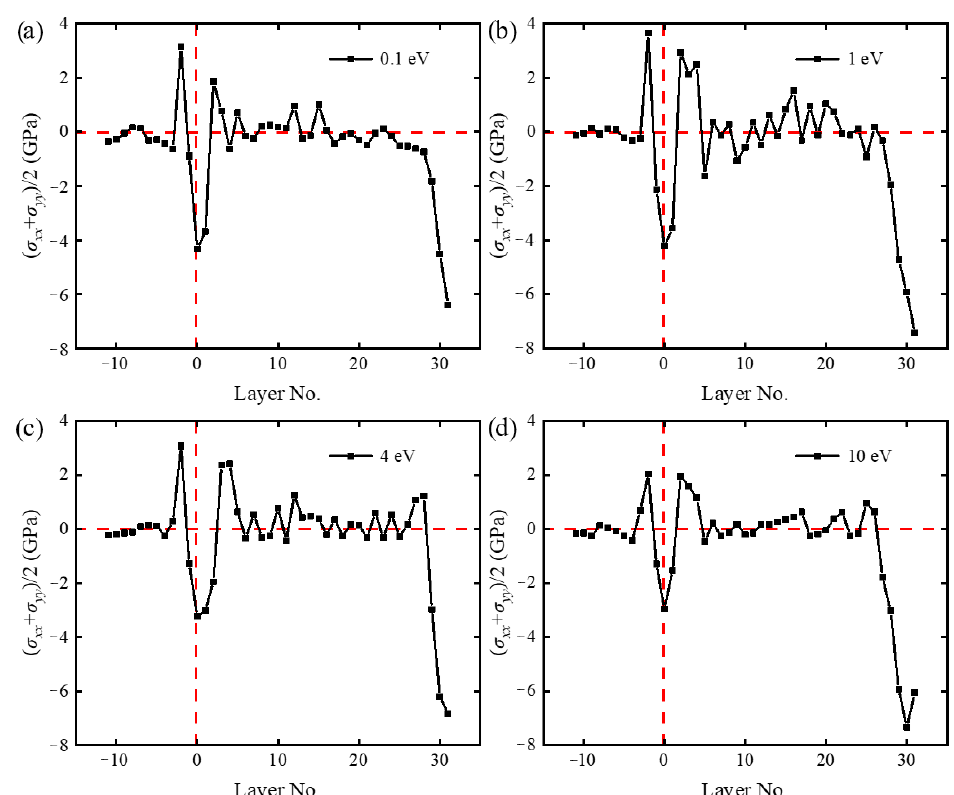
Figure 5. Biaxial stress of TiN thin films at different incident energies. ( a ) 0.1 eV; ( b ) 1 eV; ( c ) 4 eV; ( d ) 10 eV.